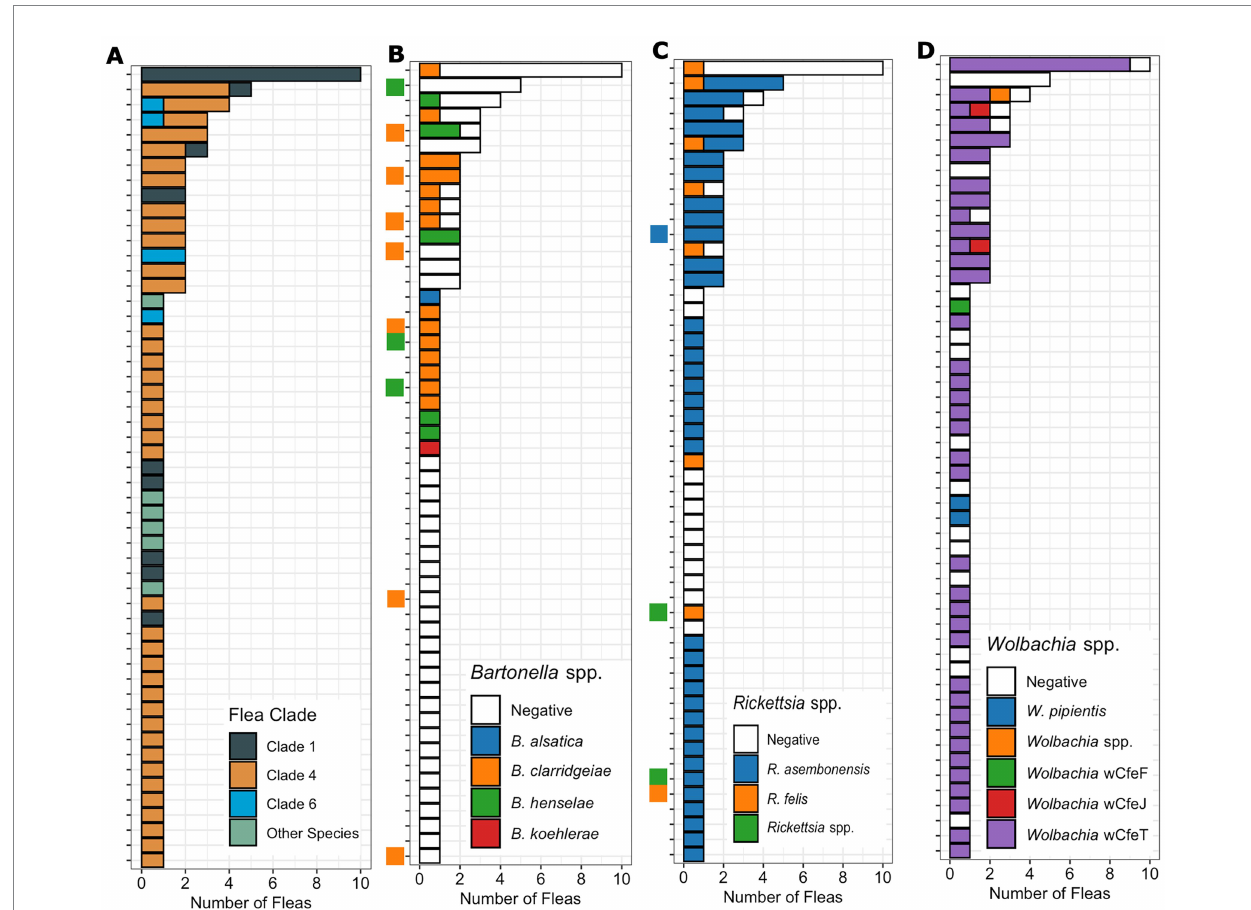
FIGURE 4 Bar chart displaying the number of fleas (x-axis) from each host (y-axis) by flea species or clade (A) as well as the Bartonella (B) , Rickettsia (C) , and Wolbachia (D) species or strains identified by qPCR. The cat host Bartonella (C) and Rickettsia (D) are indicated by a small square on the y-axis with uninfected cats left blank. The cat host is kept consistent across figure sections to allow comparison on a specific cat